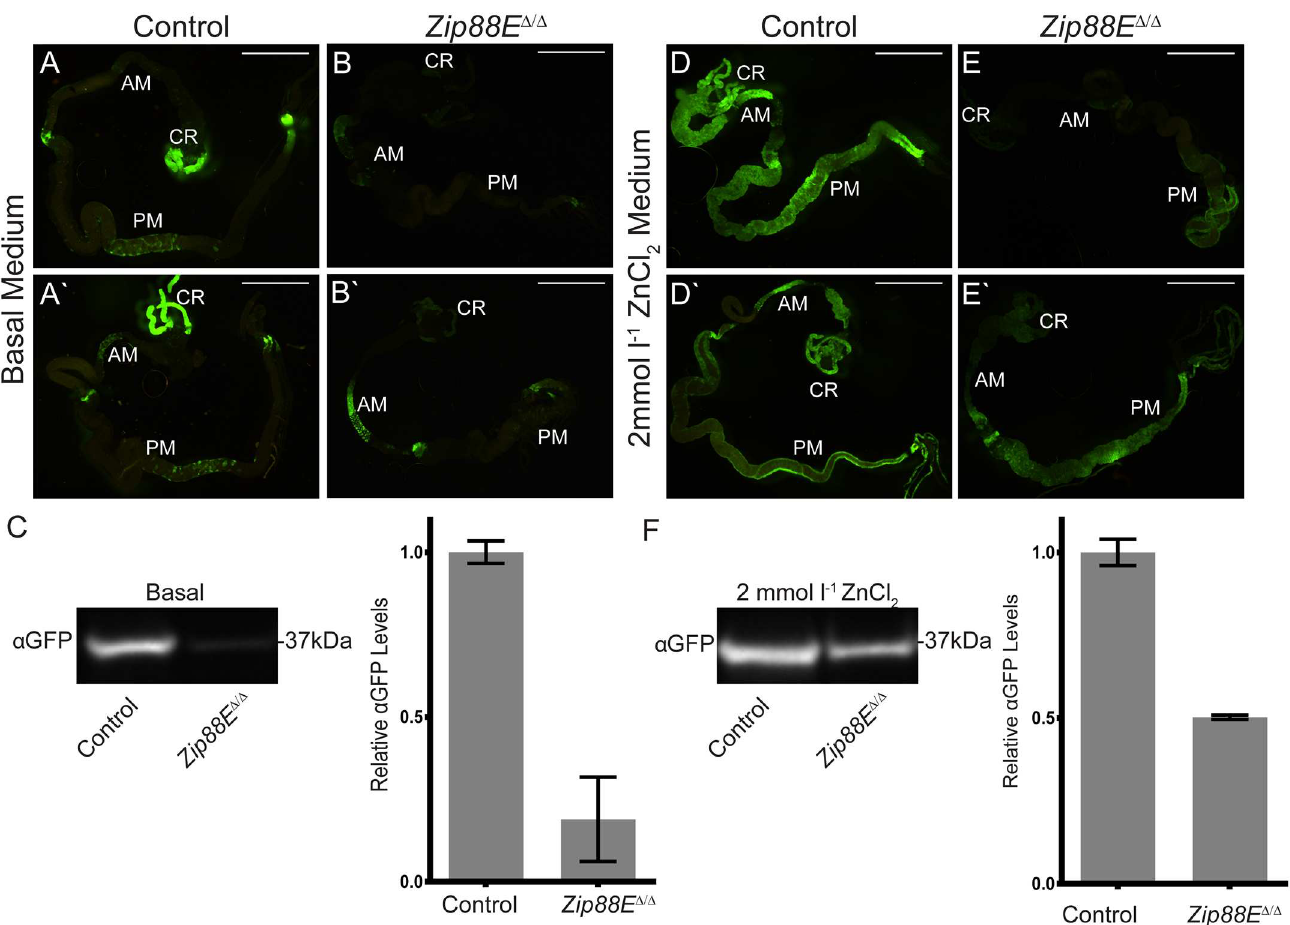
Fig 3. Zip88E Δ / Δ larvae have decreased MtnB : EYFP expression. A, B, D, E) MtnB : EYFP expressionin third instar larval midguts from control and Zip88E Δ / Δ homozygous larvae on basal medium (A and B) and after exposure to 2 mmol l -1 ZnCl 2 -supplemented medium (D, E). Variable MtnB : EYFP expressioncan be observedbetweenindividualflies, therefore an exampleof both ‘weak’ (top panel)and ‘strong’ (bottom panel)expressionhas been shown for each genotypeand treatment. Decreased MtnB : EYFP expressionis observedin Zip88E Δ / Δ midguts (B, B’, E and E’) comparedto control flies (A, A’, D and D’) on both food types. Fluorescence was observedunder dissecting microscope, images were taken with 3 second exposure. N (cid:21) 10. CR—Crop, AM—Anterior midgut, PM—Posterior midgut. Scale bars represent 1mm. C and F) Representative α -GFP western blots with protein lysate extracted from wholethird instar larvae raised on basal (C) and 2 mmol l -1 ZnCl 2 (F) media. Equivalent protein loadingwas demonstrated by PonceauS staining(S4 Fig). A singleband was detected at 37kDa (see S4 Fig for entire blot), equivalent to the predicted size of the GFP protein producedby MtnB : EYFP . Band intensity for Zip88E Δ / Δ larvae was calculatedrelative to controls and averaged over multiplewestern blots (valuesare representedas the mean ± SD, N (cid:21) 3). C) There is an approximate 5 fold decreasein MtnB : EYFP expressionin Zip88E Δ / Δ larvaecompared to controls when raisedon basal media. F) There is an approximate 2 fold decreasein MtnB : EYFP expressionin Zip88E Δ / Δ larvaecompared to controls when exposedto 2 mmol l -1